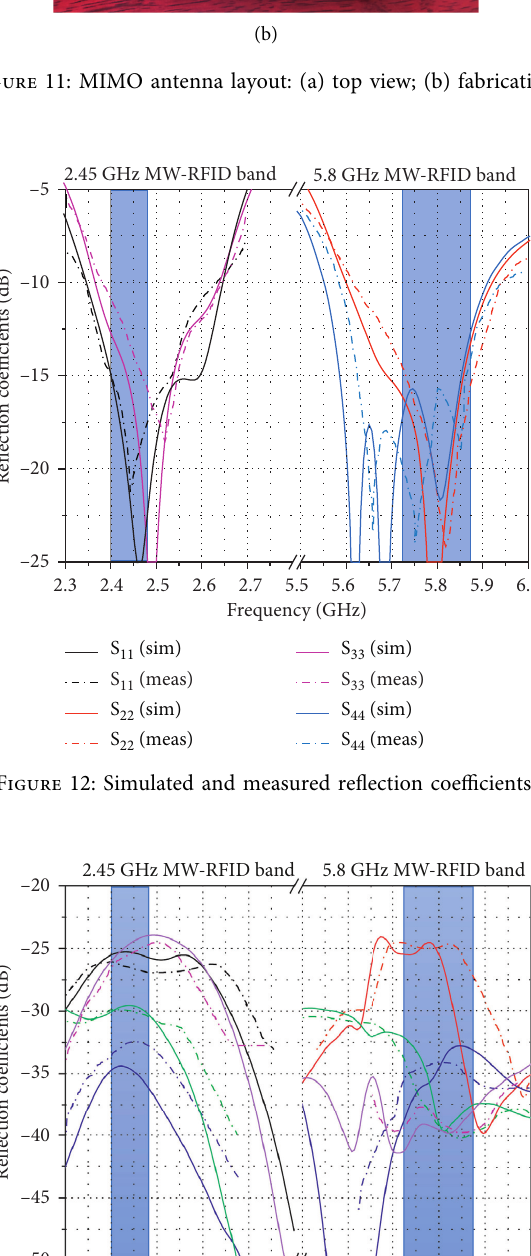
21 & 43 , S 31 , S 41 , S 32 , and S 42